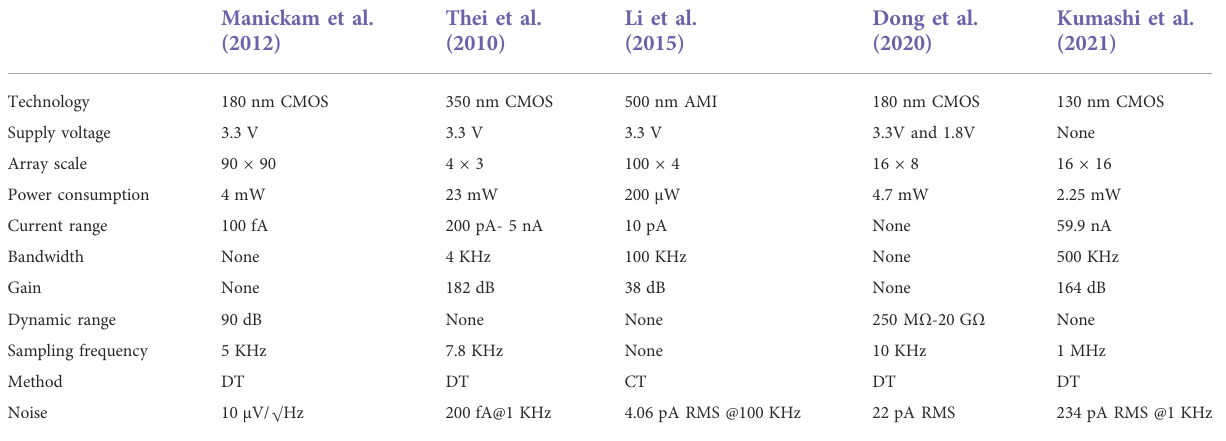
TABLE 6 Performance, summary, and comparison of achieving biosensing front-end